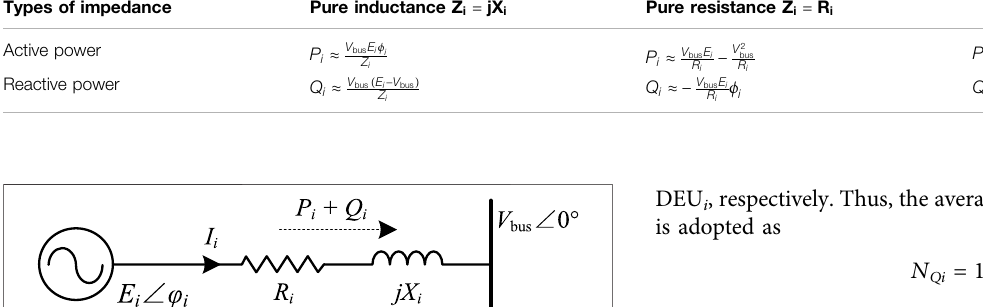
TABLE 1 | Injected powers under different types of impedances. Types of impedance